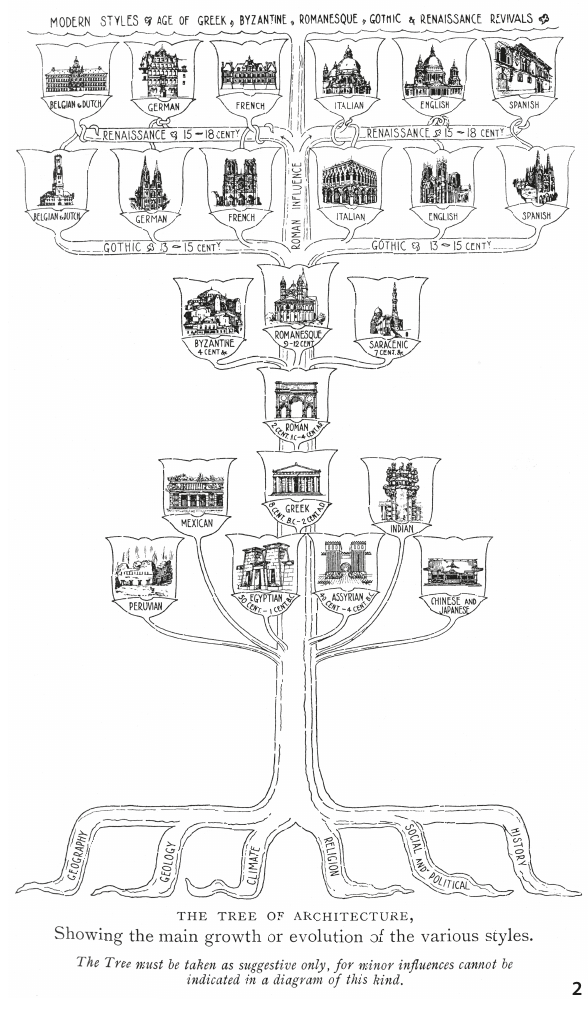
Figure 2 The ‘Tree of Architecture’, first published in 1905 in the fifth Edition of Sir Banister Fletcher’s A History of Architecture (Source: